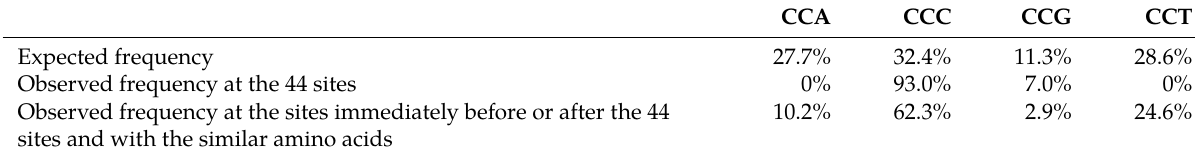
Table 3: The expected and observed frequencies of the six codons for the 9 th amino acid Proline (P9) in the protein se- quence in Figure 3C, and the observed frequencies of the six codons for P9 at the sites immediately before or after the 44 sites and with the similar amino acids as in Figure 4D.